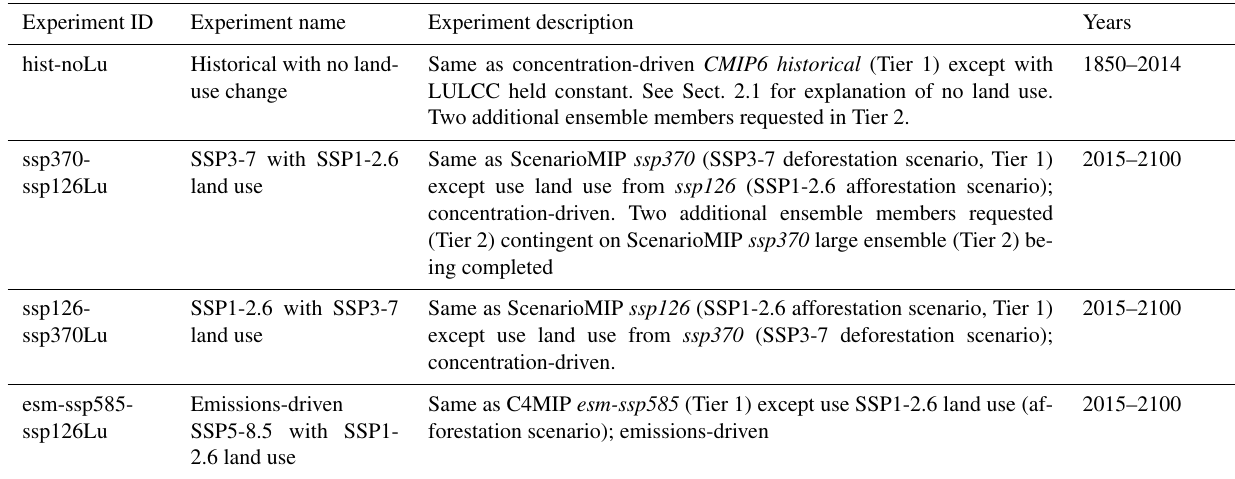
Table 3. Coupled Model Phase 2 simulations, all Tier 1.